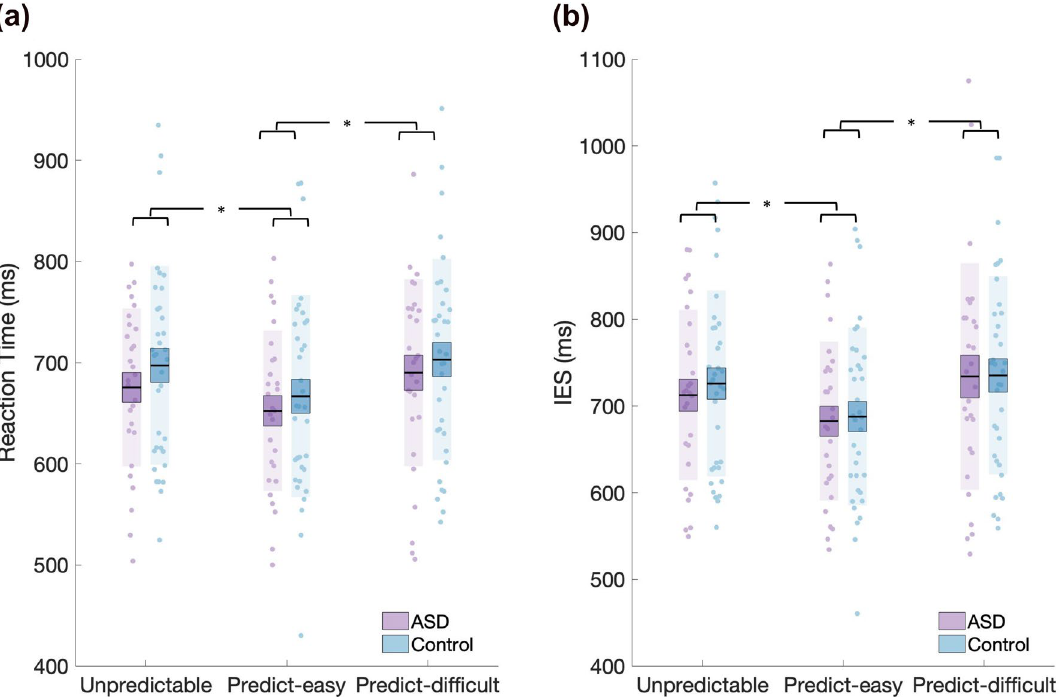
Figure 2. ( a ) Reaction time (RT). A significant difference in RT was observed between both the easy- predictable condition and the difficult-predictable and unpredictable conditions. ASD and control groups did not significantly differ in RT for any of the three conditions. ( b ) Inverse Efficiency Scores (IES). IES scores varied as a function of condition; no differences between groups were observed. Data points indicate individual participants. The mean is the thick black horizontal line and 1 standard error of the mean (SEM) is represented by the shaded box around the mean. Standard deviation (SD) is the shaded